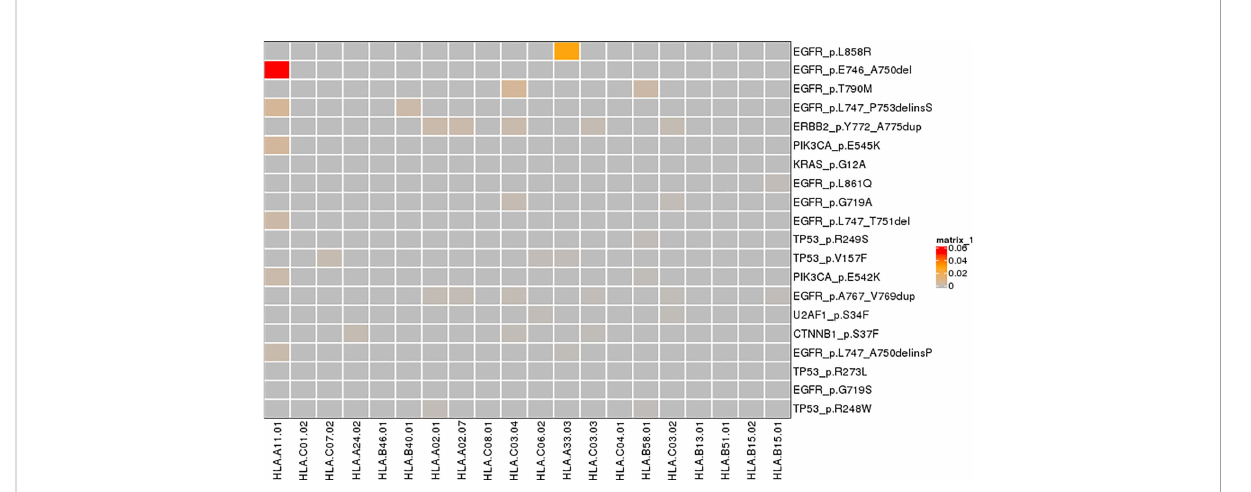
FIGURE 5 Neoantigens derived from a mutation frequency corresponding to a speci fi c HLA